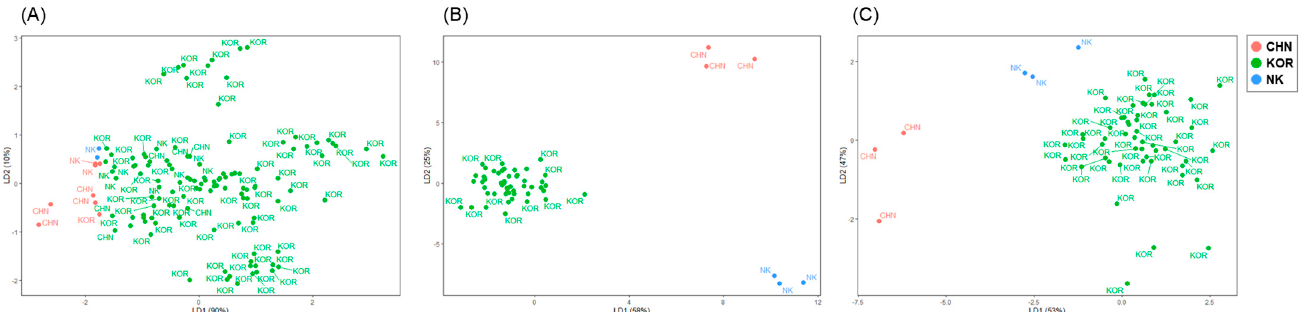
Figure 6. Linear discriminant analysis of Manila clams. ( A − C ) shows the LDA score plot of Manila clams collected from Korea, DPR Korea, and China. Each case shows the stepwise application of LDA for ( A ) dual − element isotopes, ( B ) fatty acid profiles, and ( C ) δ 13 C − FAs. Each color indicates clams from China (CHN), Korea (KOR), and DPR Korea (NK).